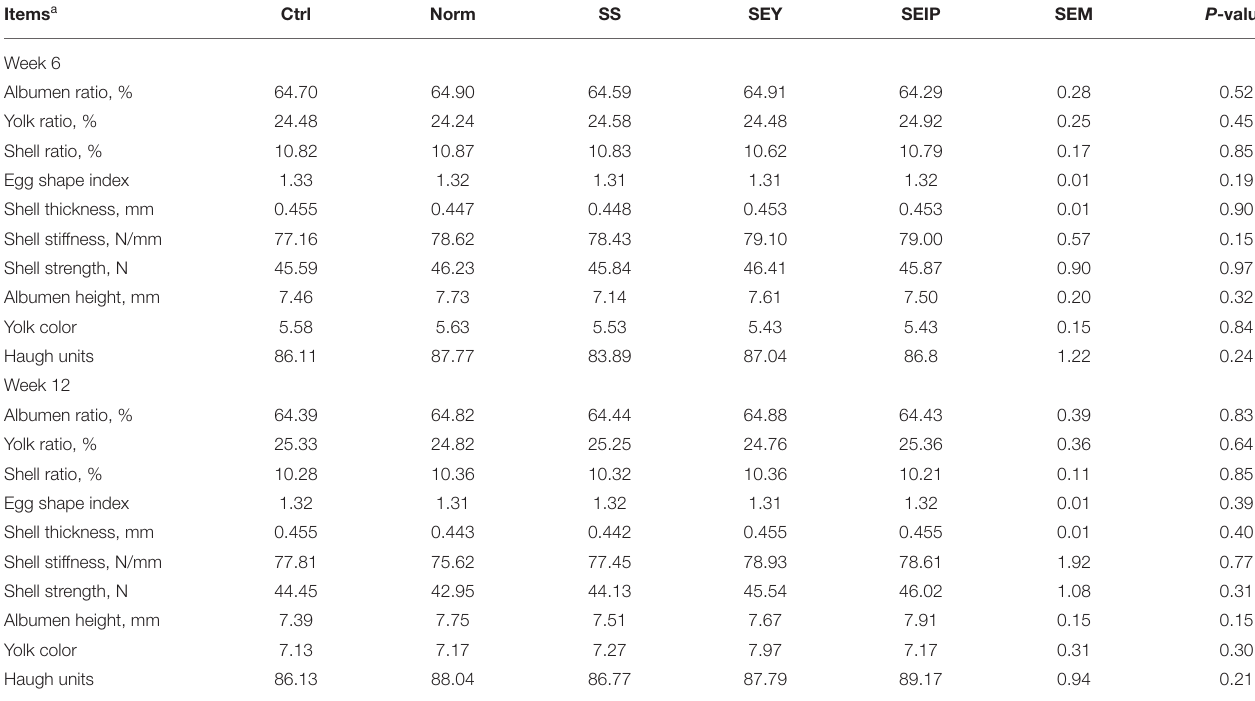
TABLE 3 | Effects of dietary Se sources on egg quality of laying hens.